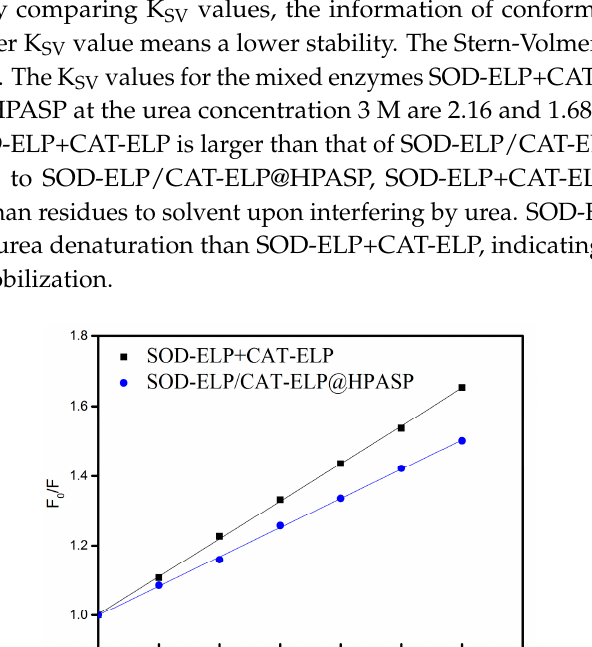
Figure 5. Circular dichroism (CD) spectra for two mixed enzymes SOD-ELP+CAT-ELP (blue) and co-immobilized enzymes SOD-ELP/CAT-ELP@HPASP (red).